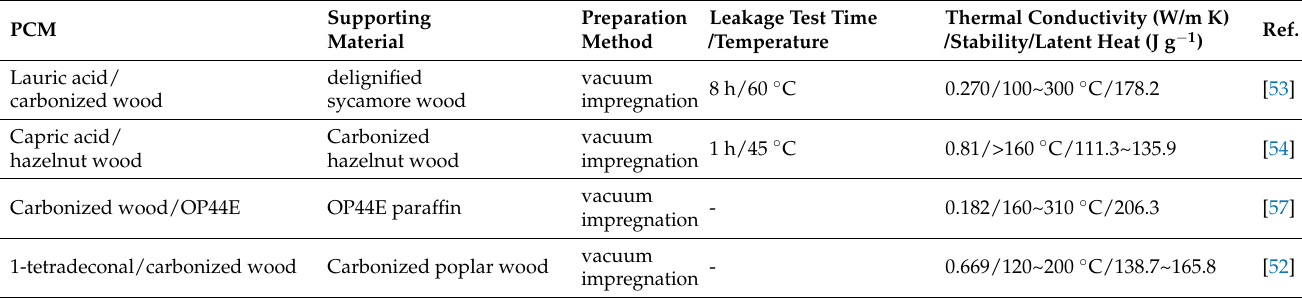
Table 3. Physicochemical parameters of selected PCM materials discussed in this